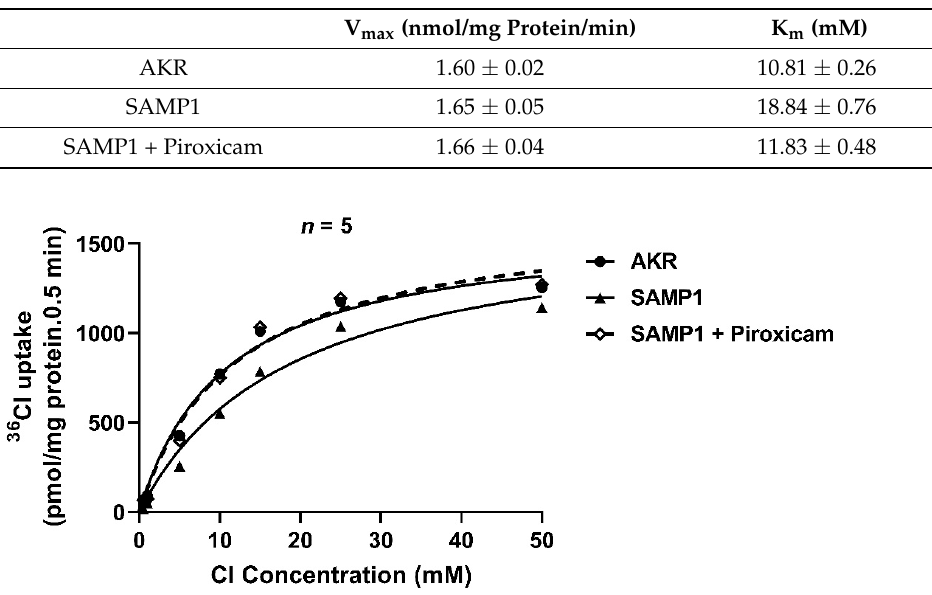
Figure 5. Kinetics of Cl − /HCO 3 − exchange in villus cells from AKR, SAMP1, and piroxicam-treated SAMP1 mice. DIDS-sensitive 36 Cl uptake in different groups is shown as a function of varying concentrations of extracellular Cl − . Analysis of the kinetic parameters (K m and V max ) by GraphPad Prism software showed no significant alteration of V max in all the groups. In SAMP1 mice, there was a significant increase in K m (decrease in 1/K m ) ( n = 5) compared to AKR mice. Piroxicam treatment restored the K m to normal, comparable to that of AKR mice.